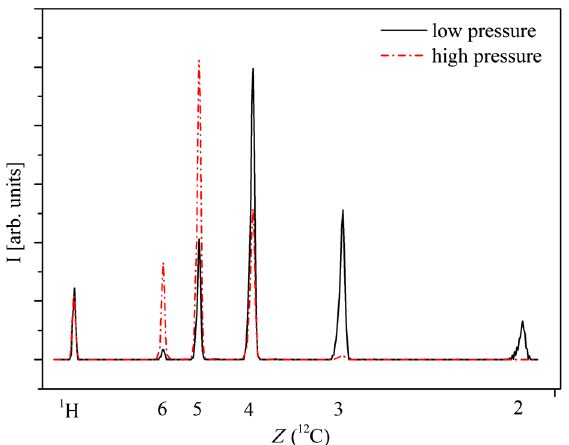
FIG. 7. Measured gas stripper spectrum of the CH 3 þ beam from the HSI. Above a threshold (black) the proton beam intensity is independent on the N 2 -target density, while the carbon beam could be optimized for higher Z (red)